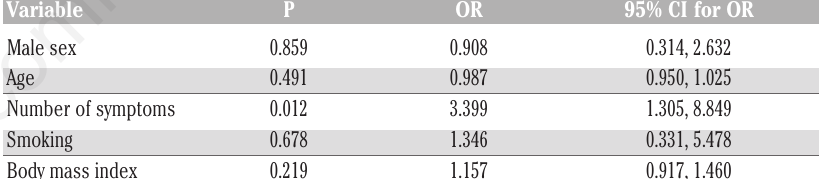
Table 3. Binary logistic regression test of factors associated with cerebral venous throm- bosis.